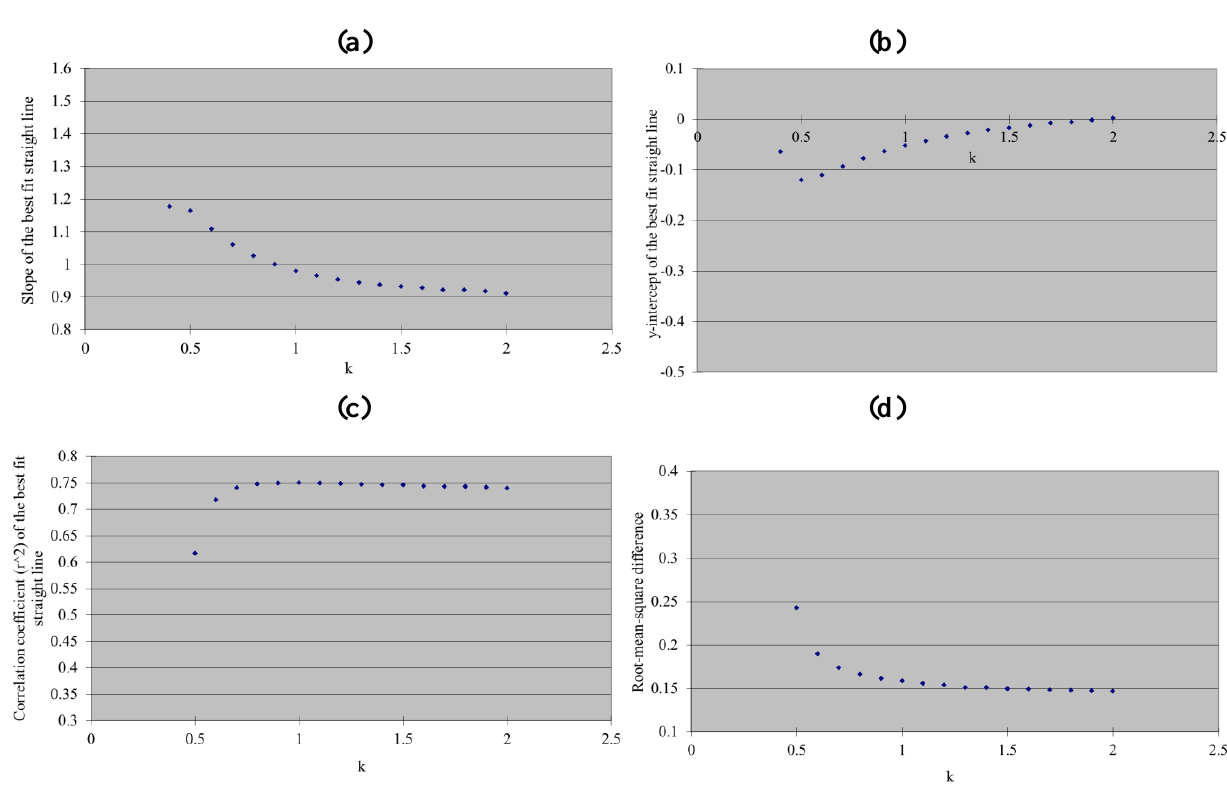
Figure 4. Variation of the following quantities with k: (a) slope, (b) y-intercept, and (c) correlation coefficient of the best fit straight line, and (d) root-mean-square difference, between AOD from LIDAR and AOD from sun photometer during the period July 2009 to May 2010.